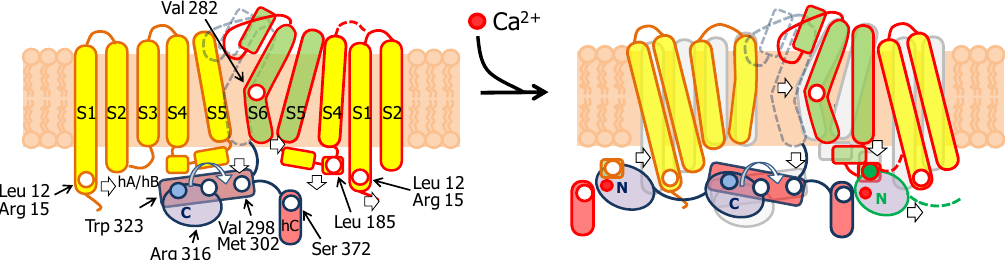
Figure 6. Cartoon representation of the coordinated movements upon SK4 activation. Same coloring scheme as in Figure 4. Part of the PD of the blue subunit is represented with dashed lines. Note that the complete ViSD of the red delimited subunit has not been represented to simplify the scheme. Also, S3 of the red delimited subunit, as well as the ViSD and S6 of the blue subunit have been left out. The main CaM anchoring residues Leu 185 in helix A and Trp 323 in helix B are filled with the color of its corresponding subunit when engaged with CaM. The remaining residues contact CaM as indicated in the main text, represent the axis or helix A / B rotation (Arg 316), or constitute the pore gate (Val 282). The border of CaM is colored according to the subunit engaged with the C-lobe. Note that the N-lobe of blue CaM interacts with helix C of a red subunit, and S1 of an orange subunit.